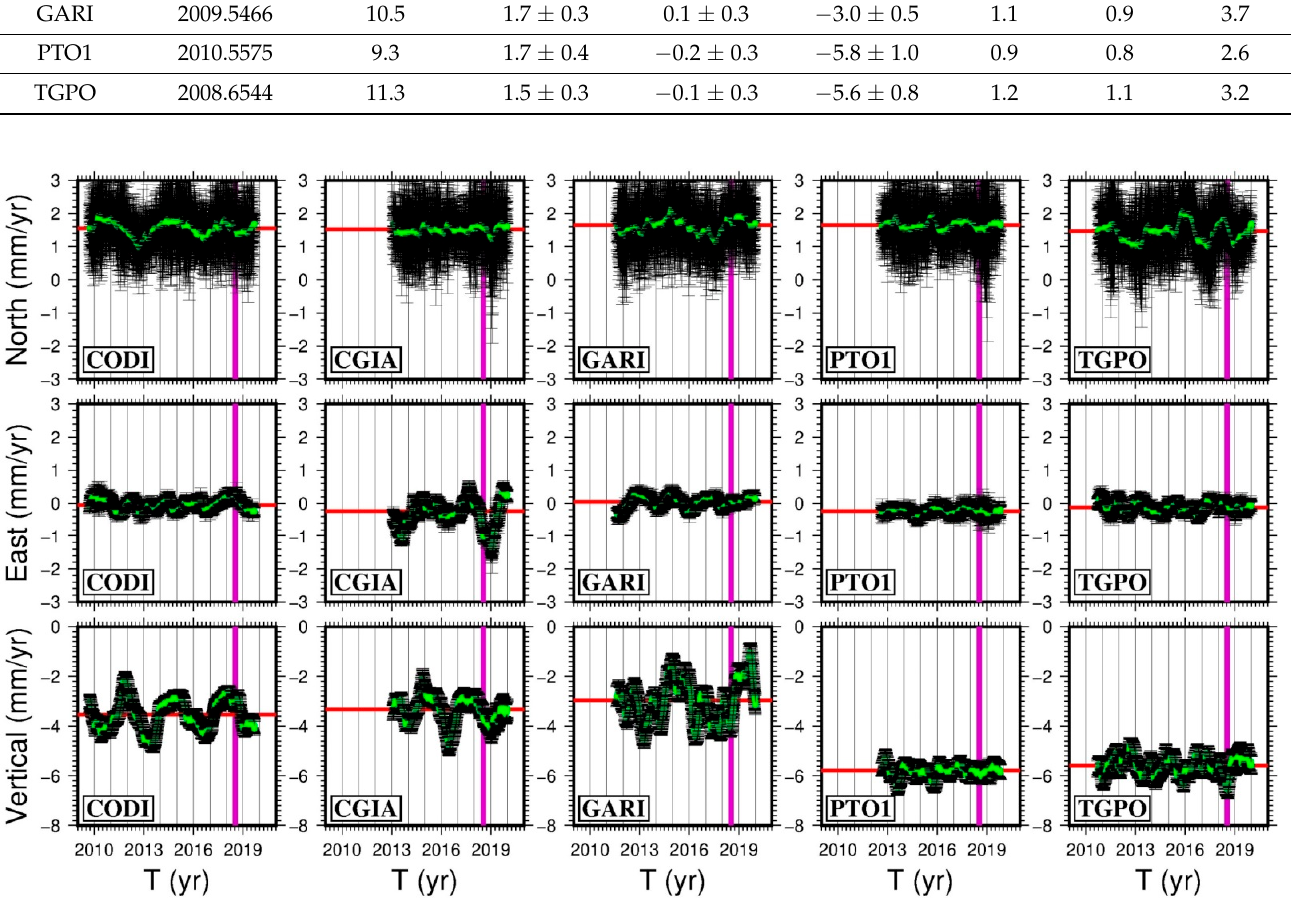
Figure 3. IV time-series of the CGNSS sites located in the PRD area obtained using the Velocity Moving Window Approach (VMWA) with a window of 755 days (21 June 2016–18 July 2018). The windows containing less than 300 days were rejected. The black bars represent the uncertainties associated with the IV. The horizontal red lines represent the velocities obtained using the entire time-series and reported in Table 1. The purple vertical line represents the data related to the last day of the second PODELNET survey (18 July 2018). The IV associated with this data are the values corresponding to the time span between the two measurements.